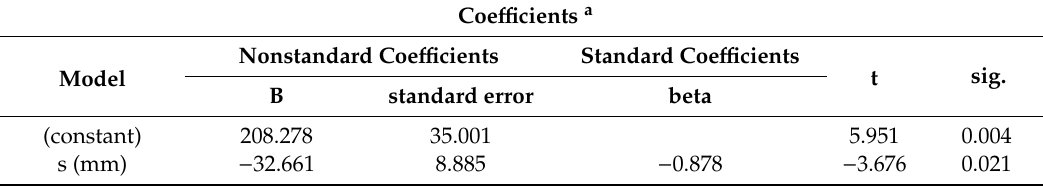
Table 7. Linear regression coe ffi cients for topographic settlement test and first modulus of PLT ( Φ